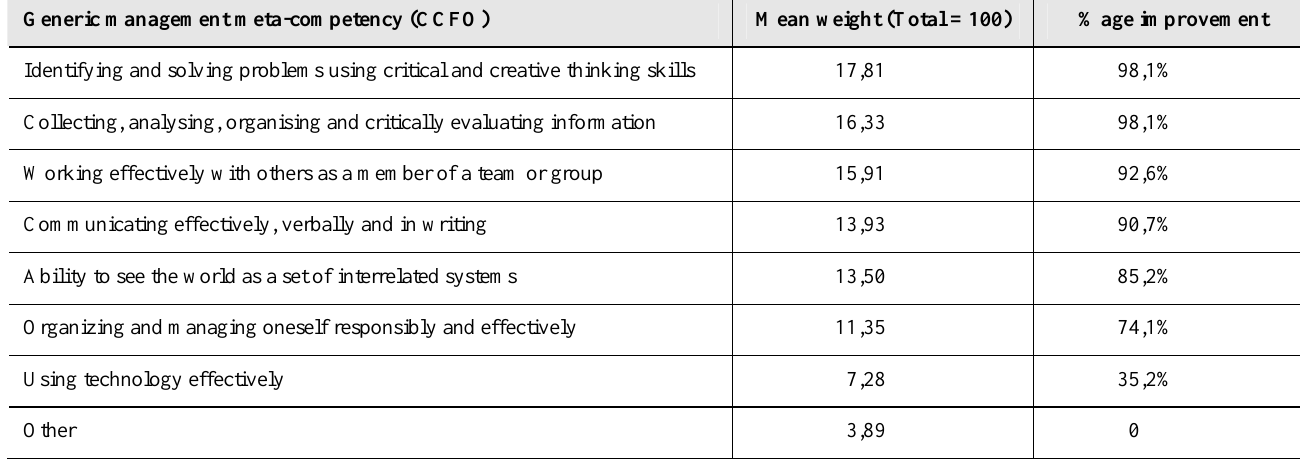
Table 1: Perceived importance and extent of improvement of SAQA’s assessable critical cross-field outcomes by